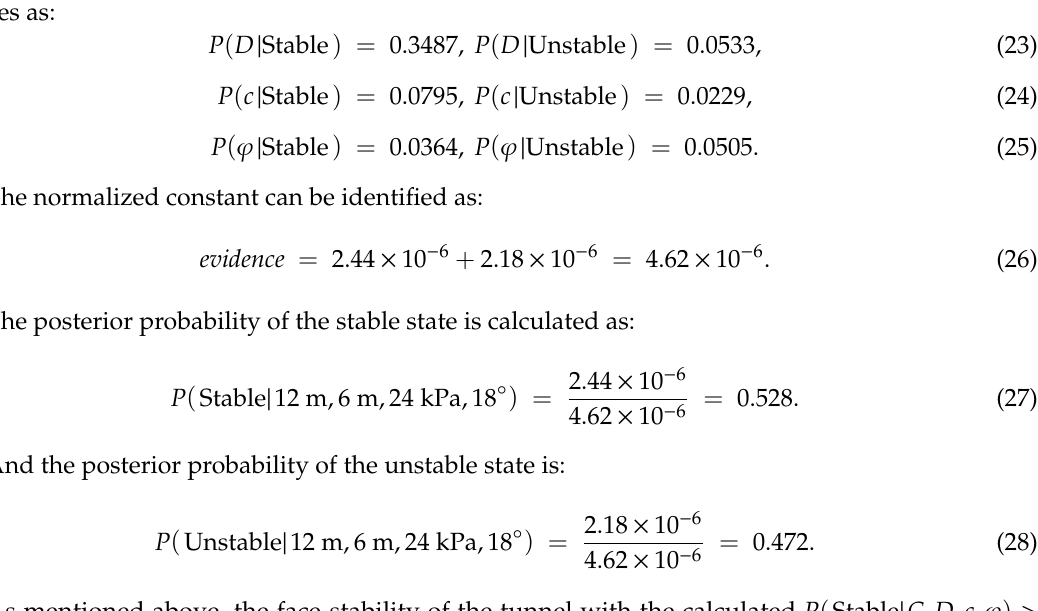
( b ) Figure 7. Error estimation for the first classifier. ( a ) Stable probability of the samples with 𝐹 𝑠 ≥ 1 ; ( b ) unstable probability of the samples with 𝐹 𝑠 < 1 . Results in Figure 7 show that 18 of the 45 stable samples were predicted to be unstable. The error rate estimated for the stable samples (40%) is the well-known indicator of type I error, which is an underestimation of the face-stability. The safety factors of the error estimations range from 1.01 to 1.15, which indicates that type I error is more likely to happen when the face-stability of a tunnel is